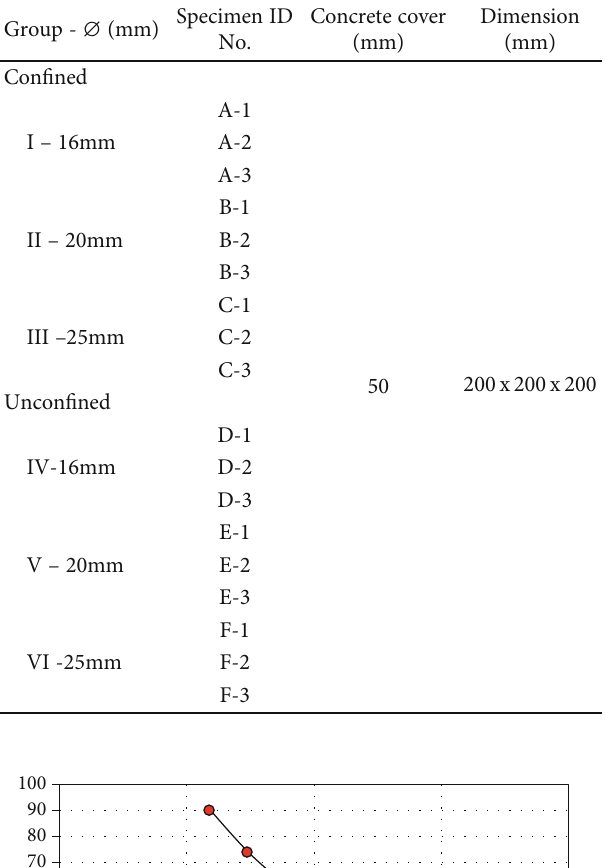
Table 2: Materials proportion of designed concrete mix (unit: